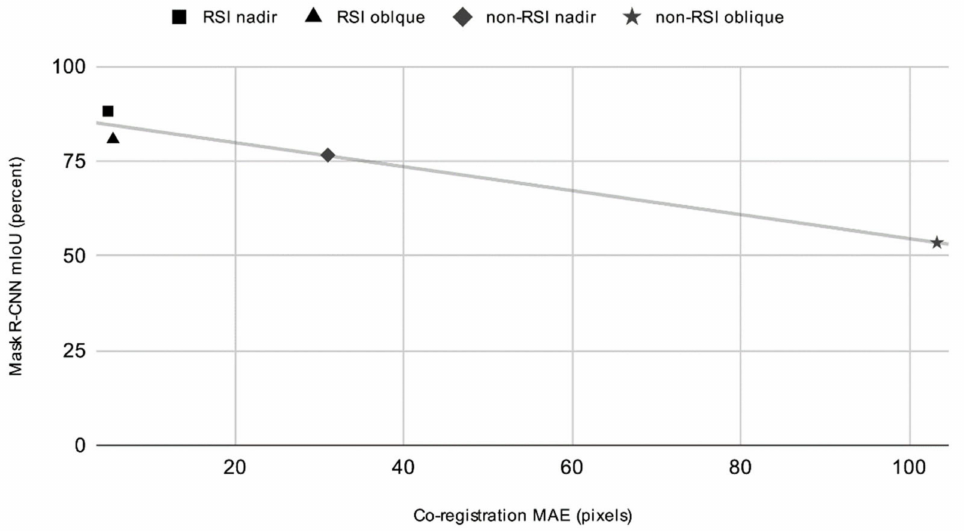
Figure 7. Relationship between the Mask R-CNN (mIoU) and co-registration (MAE) accuracies by RSI, non-RSI acquisition methods and nadir, oblique view